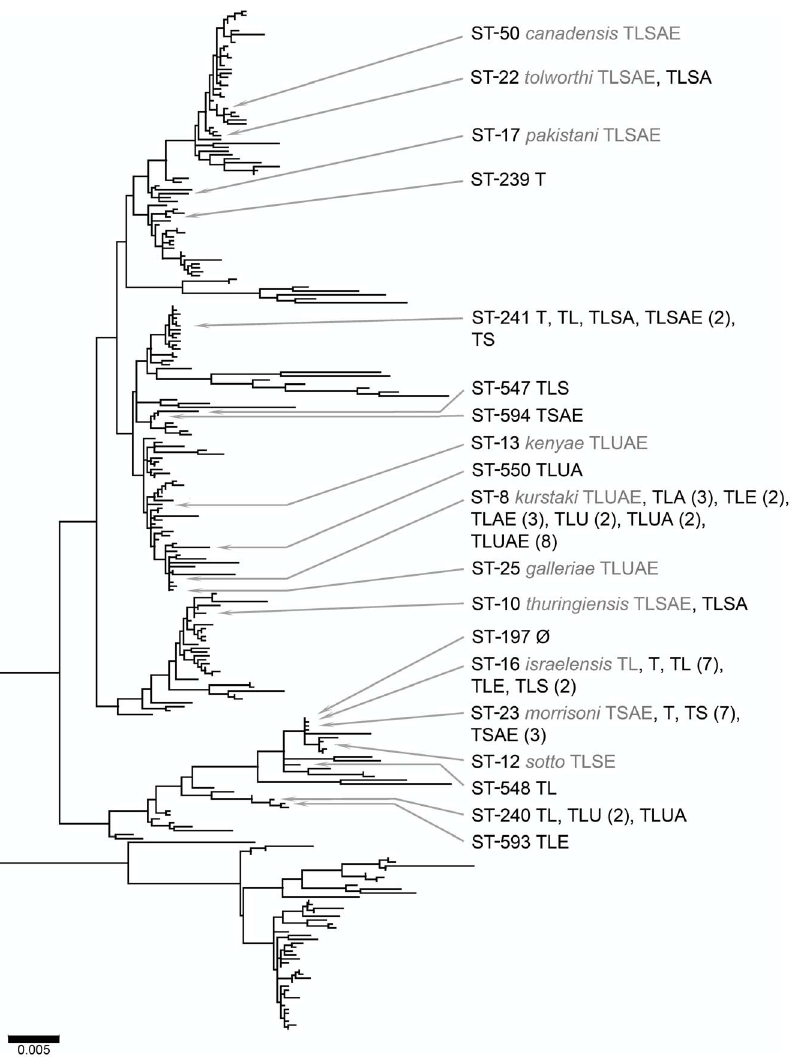
Figure 2. Un-rooted maximum likelihood analysis of Clade 2, with sequence types and corresponding phenotypes found in our sample indicated. Numbers in parentheses indicate the number of isolates with the indicated phenotype observed in the ST. Light text indicates varieties and phenotypes described by de Barjac [3].